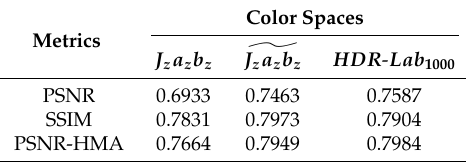
(cid:94) J z a z b z and HDR - Lab 1000